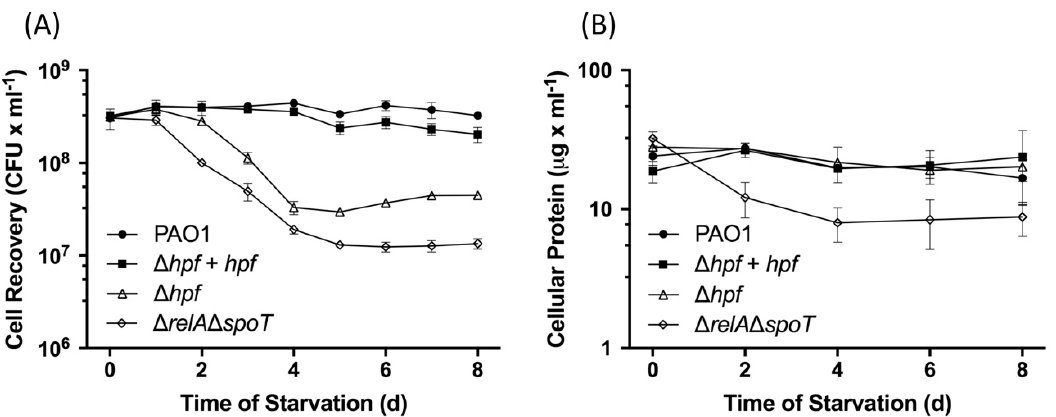
Figure 2. ( A ) Resuscitation of P. aeruginosa PAO1, P. aeruginsoa ∆ hpf , P. aeruginsoa ∆ hpf complemented with hpf on a plasmid, and P. aeruginsoa ∆ relA ∆ spoT over the course of starvation at 37 C in phosphate buffered saline (PBS). Cultures were diluted to give approximately the same initial concentration of cells. Resuscitation was assayed as colony forming units (CFUs). ( B ) Cellular protein abundances of P. aeruginosa strains over the course of starvation. Data show the mean and standard deviation for three replicates.